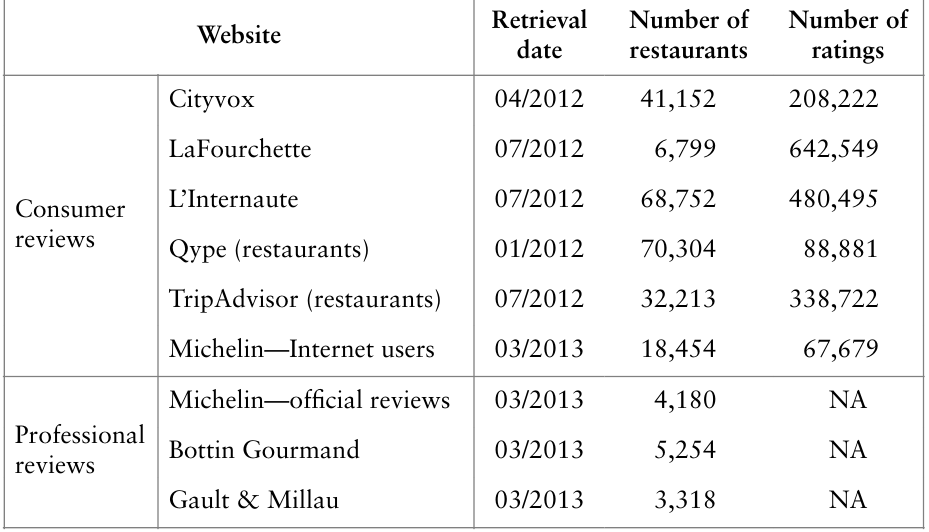
Table 1. Basic OCR website data.